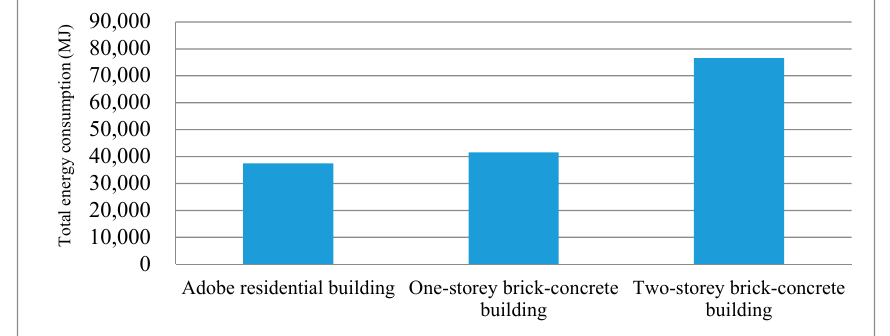
Figure 8. Energy demand of building erection (MJ). Energies 2020 , 13 , x FOR PEER REVIEW